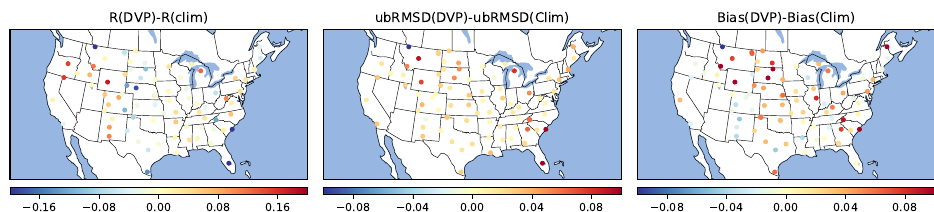
Figure 6. Difference in the Pearson correlation coefficient (R), unbiased RMSD and bias between in situ soil moisture and soil moisture retrieved using vegetation parameters derived using Dynamic Vegetation Parameters (DVPs) (hw = 21) and those derived from climatological